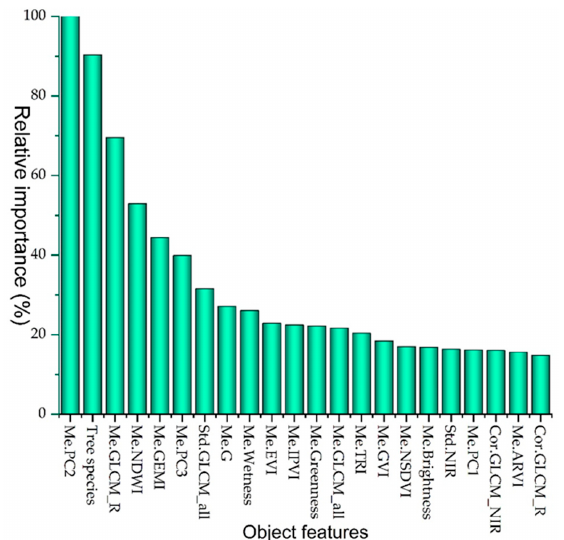
Figure 3. The importance of top predictor variables of Landsat 8 OLI and ancillary features for discerning insect-infested from the non-insect-infested objects using TreeNet. The most important predictor variable (i.e., the mean of the second principal component, or PC2) has gained a value of 100%, and other features were rescaled based on their importance relative to the PC2. The TreeNet model was rebuilt with respect to the top influential object features that have gained a minimum score of 15% importance relative to the most important variable. The